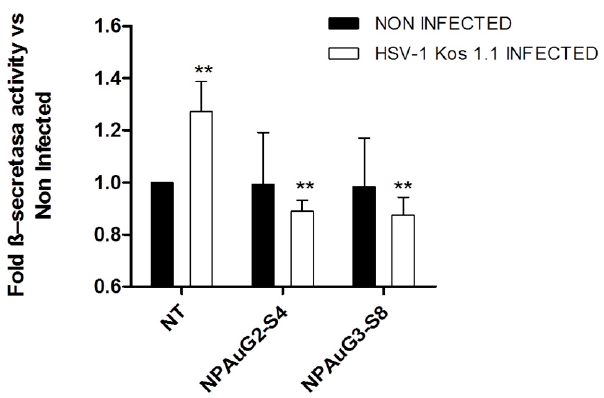
Figure 6. Levels of β -secretase activity in the SK-APP-D1cell line. SK-APP-D1cells were treated with NPAus, or NPAus infected with HSV-1. Data represent mean ± SD of three independent experiments performed by triplicate. ***: p < 0.001; **: p < 0.01; *: p < 0.05. NT: SK-APP-D1 cells. Statistical analysis vs SK-APP-D1 non-treated control cells.